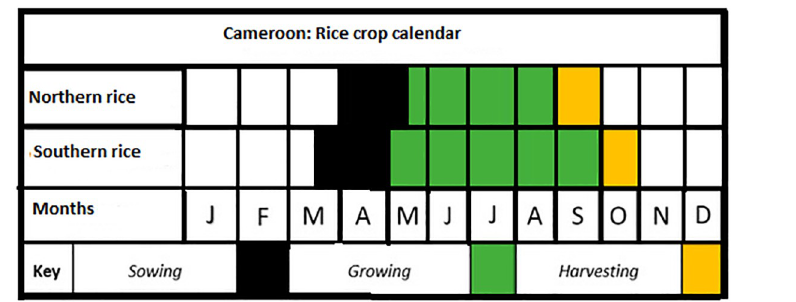
Fig 5. Rice crop calendar for Cameroon. Source: Authors’